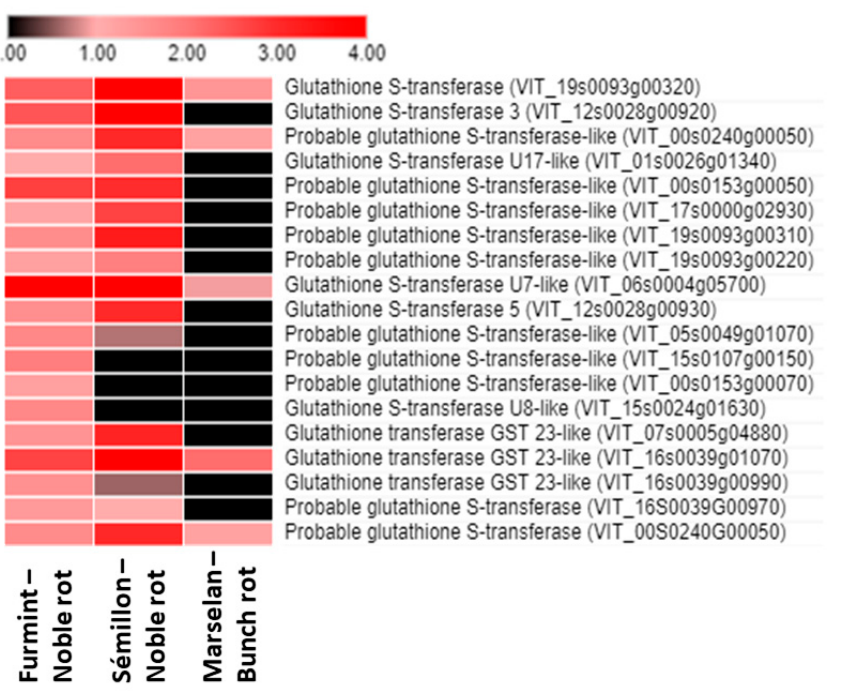
Figure 6. Heat map diagram showing the transcript abundance (Log2 fold change) of a set of V. vinifera glutathione S-transferase ( GST ) genes in Furmint, S é millon, and Marselan cultivars. Fold induction results are presented after Log2 transformation. Noble rot affects the expression of GST transcripts more robustly than bunch rot does. Transcriptome data for Furmint stage I. noble rot was analyzed in this study and S é millon stage II. noble rot samples [7] are displayed as they appear most comparable by macroscopic observation of the berries. Concerning the bunch rot dataset, mRNA expression results of mature Marselan berries [2] collected 48 h after inoculation with B. cinerea are presented.